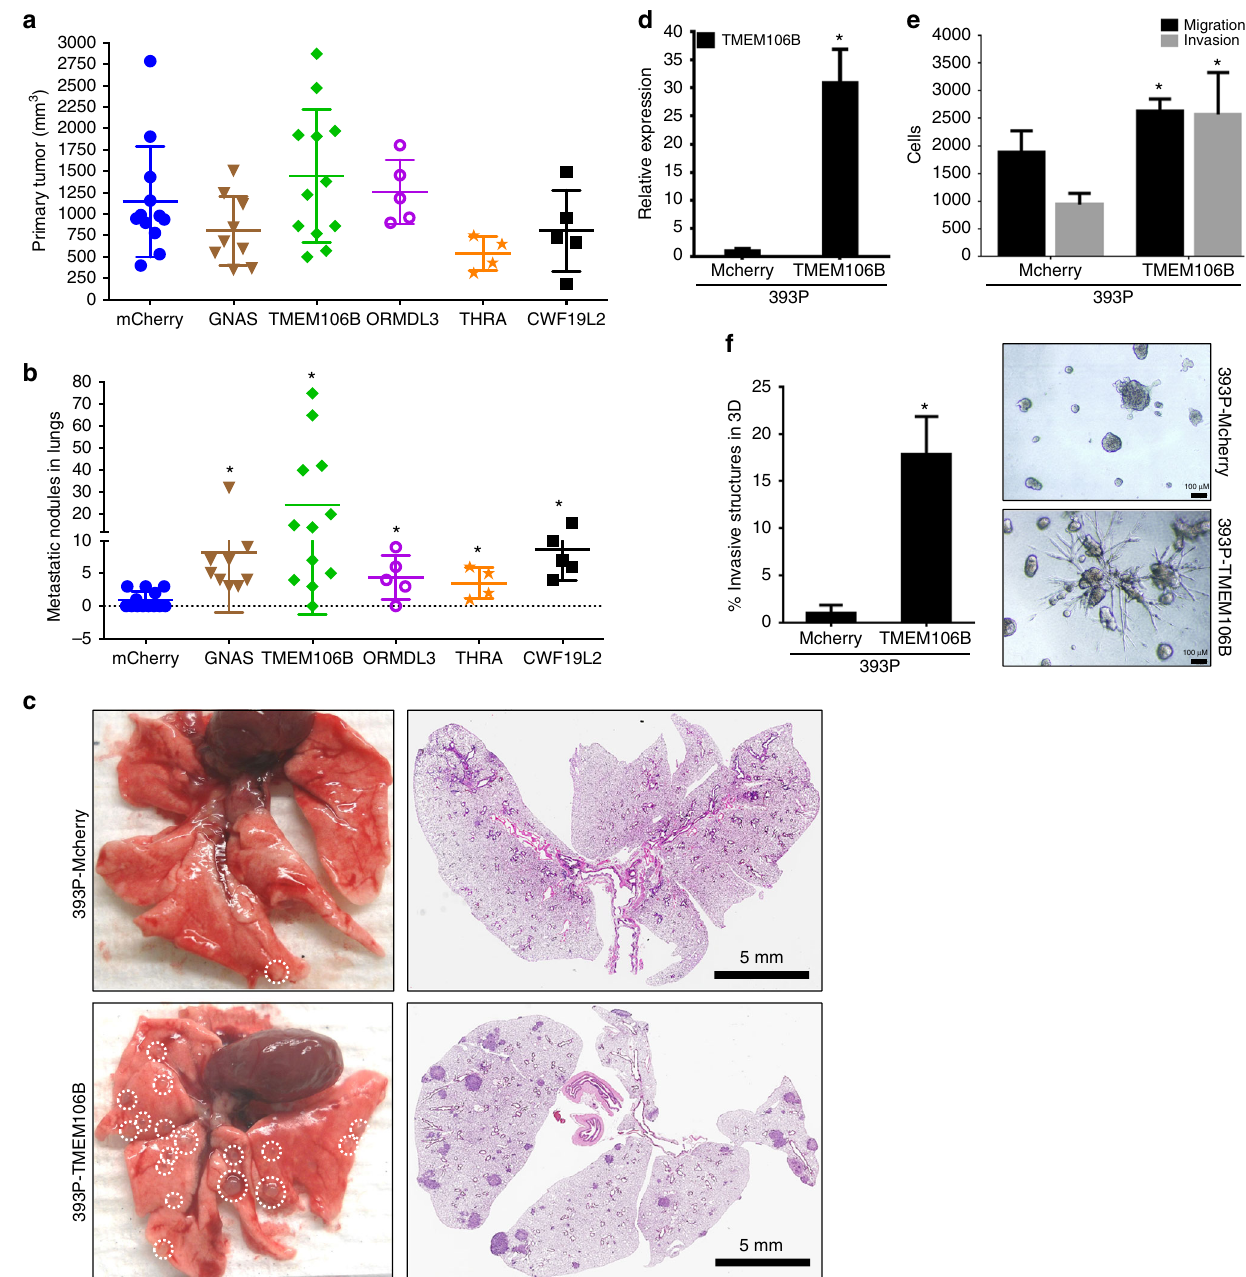
Fig. 1 TMEM106B is a novel driver of invasion and metastasis in lung cancers. a Primary tumor growth for 393P cells overexpressing individual hits (as indicated), identi fi ed in the in vivo screen 5 were injected subcutaneously into syngeneic hosts and observed for primary tumor growth and b lung metastasis. c Representative lungs and their respective H&E sections are shown. Lungs from mice injected with TMEM106B-expressing cells show signi fi cantly more incidence of lung metastasis. d qPCR analysis for TMEM106B expression in 393P cells overexpressing TMEM106B. e Cells overexpressing TMEM106B showing signi fi cant increase in migration and invasion compared to Mcherry are indicated. f TMEM106B overexpressing cells form signi fi cantly more number of invasive spheroids compared to Mcherry when seeded in 3D matrix comprising of matrigel and collagen. All asterisks indicate statistical signi fi cance by T test ( n ≥ 3, * p ≤